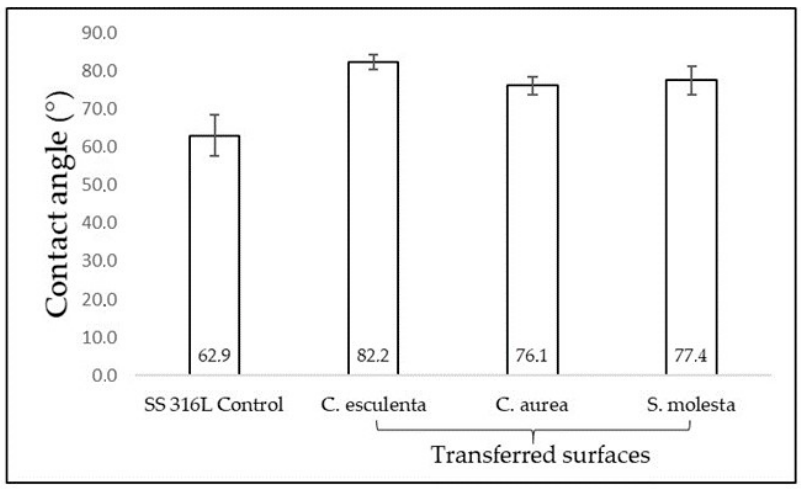
Figure 4. Contact angle measurements from control (SS 316L) and transferred (experimental) surfaces.